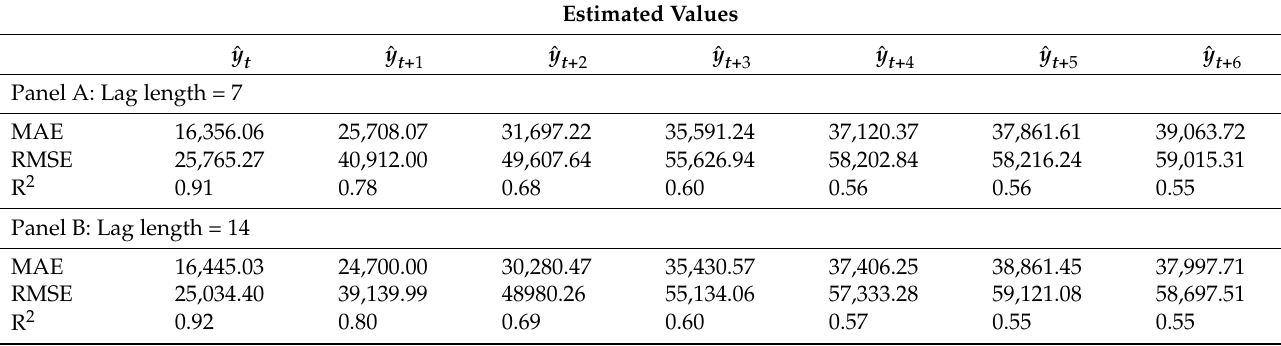
Table 5. Performance metrics of CNN on train set for different lag